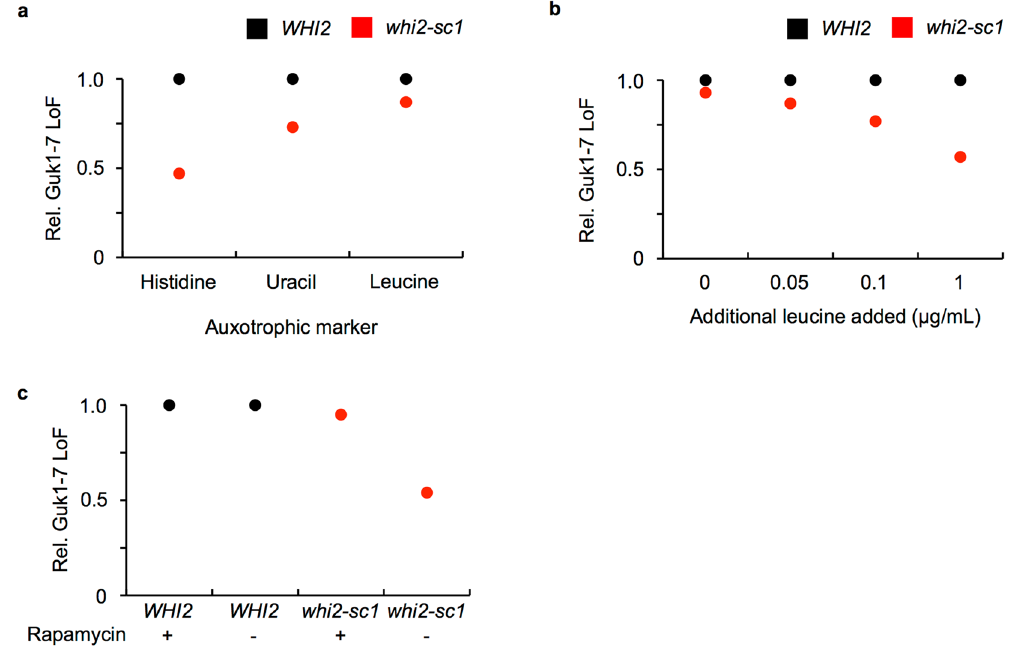
Figure 6. Deficient proteostatic response under conditions where the TOR pathway is active. ( a ) Guk1-7-GFP was expressed from CEN/ARS plasmids with histidine, uracil, or leucine auxotrophic markers in wild type or whi2-sc1 cells. Cultures were incubated with CHX for two hours at 25°C or 37°C before being analysed by flow cytometry. ( b ) Wild type and whi2-sc1 cells were co-transformed with Guk1-7-GFP and pRS315 ( LEU2 ). Cultures were grown in synthetic drop out media containing the indicated amounts of leucine and then incubated for two hours in the presence of CHX at 25°C or 37°C before flow cytometry analysis. ( c ) WHI2 and whi2-sc1 cells were handled as in ( a ) except for being treated with 200 nM rapamcyin for two hours at 25°C prior to the two hour incubation at 25°C or